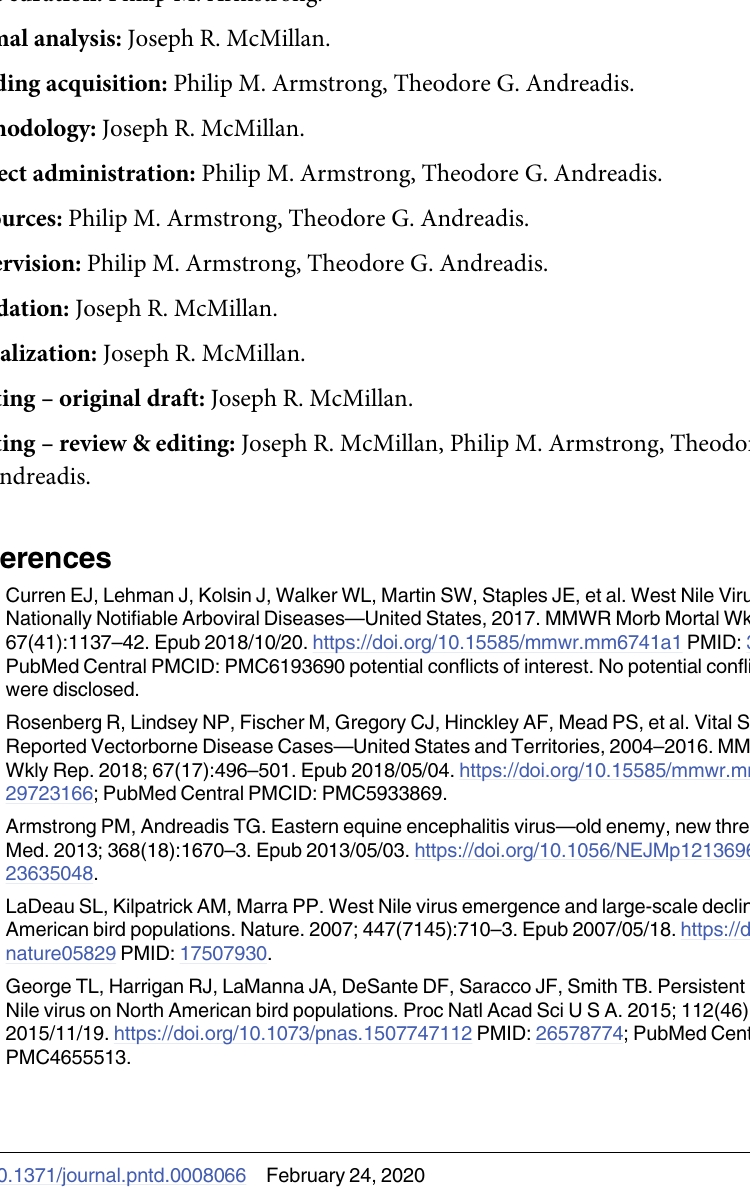
S2 Fig. Color legend for Figs 4 and